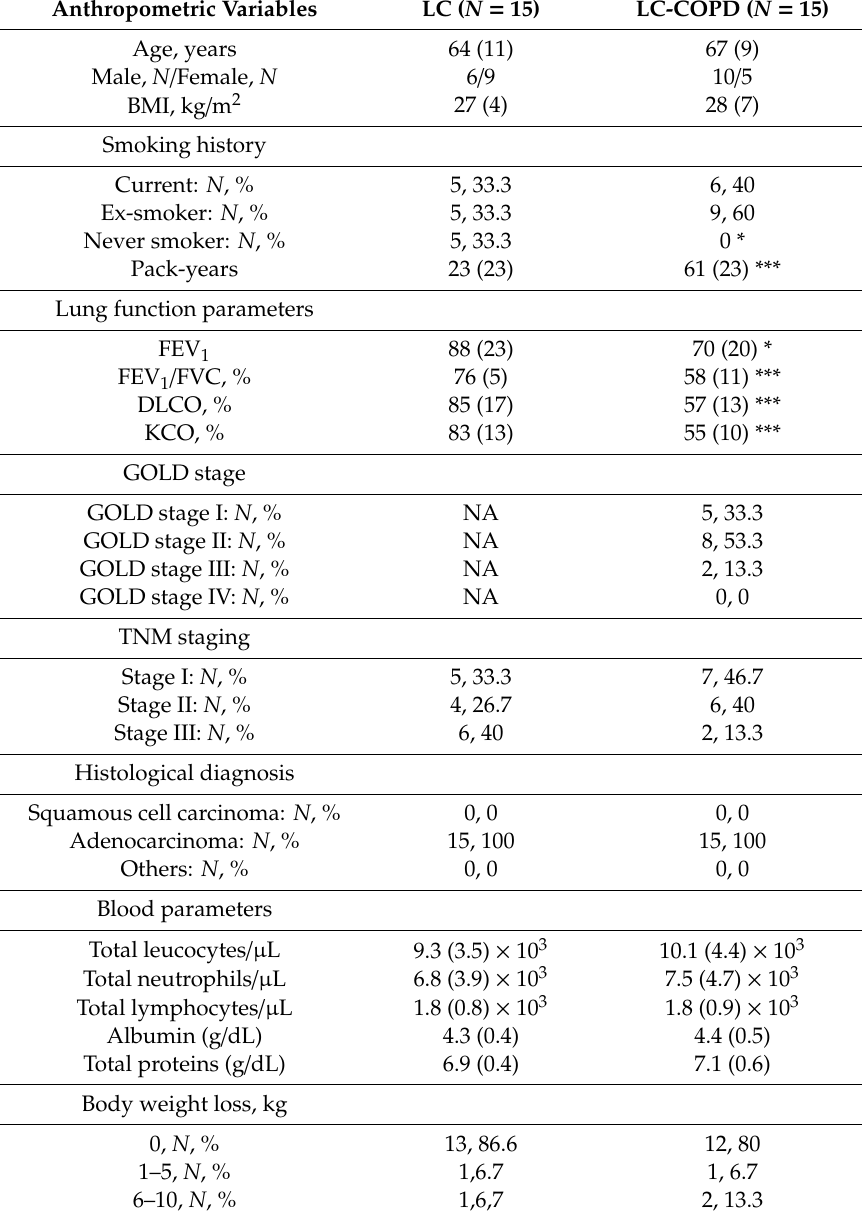
Table 1. Clinical and functional characteristics of the study